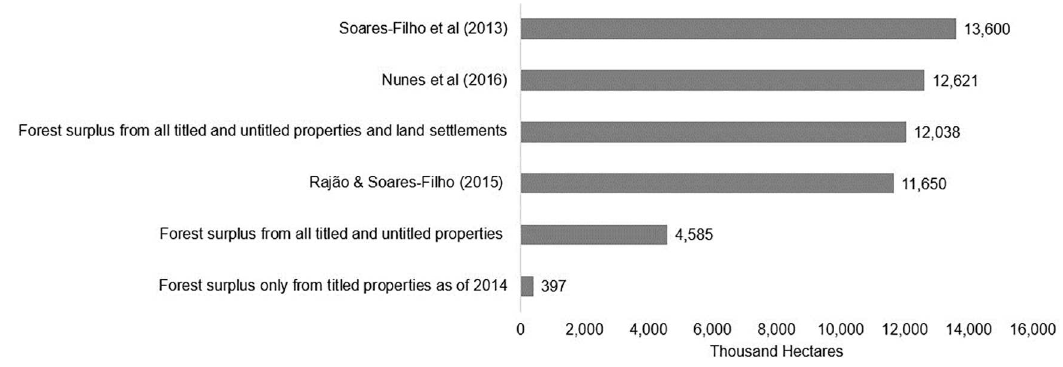
Fig 5. Comparison of CRA supply scenarios with previous